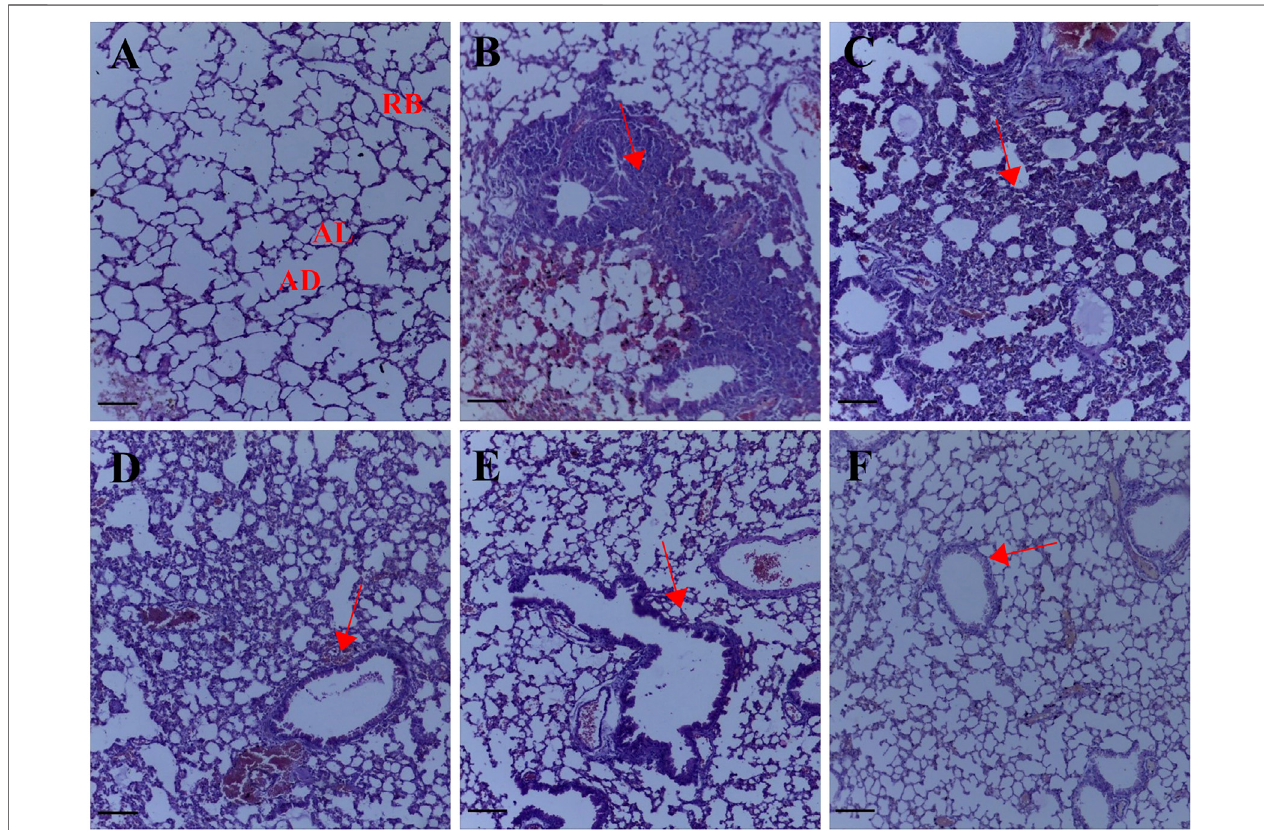
FIGURE 2 | Representative photomicrographs of the lung H& E sections. (A) Normal saline (B) lung metastasis (C – E) Palmatine 1 – 10 mg/kg (F) Doxorubicin 5 mg/kg; AL, alveolus; AD, alveolar duct; RB, respiratory bronchiole. Red arrows show metastatic alterations. Scale bar 20 mm ×10, (A – F) .